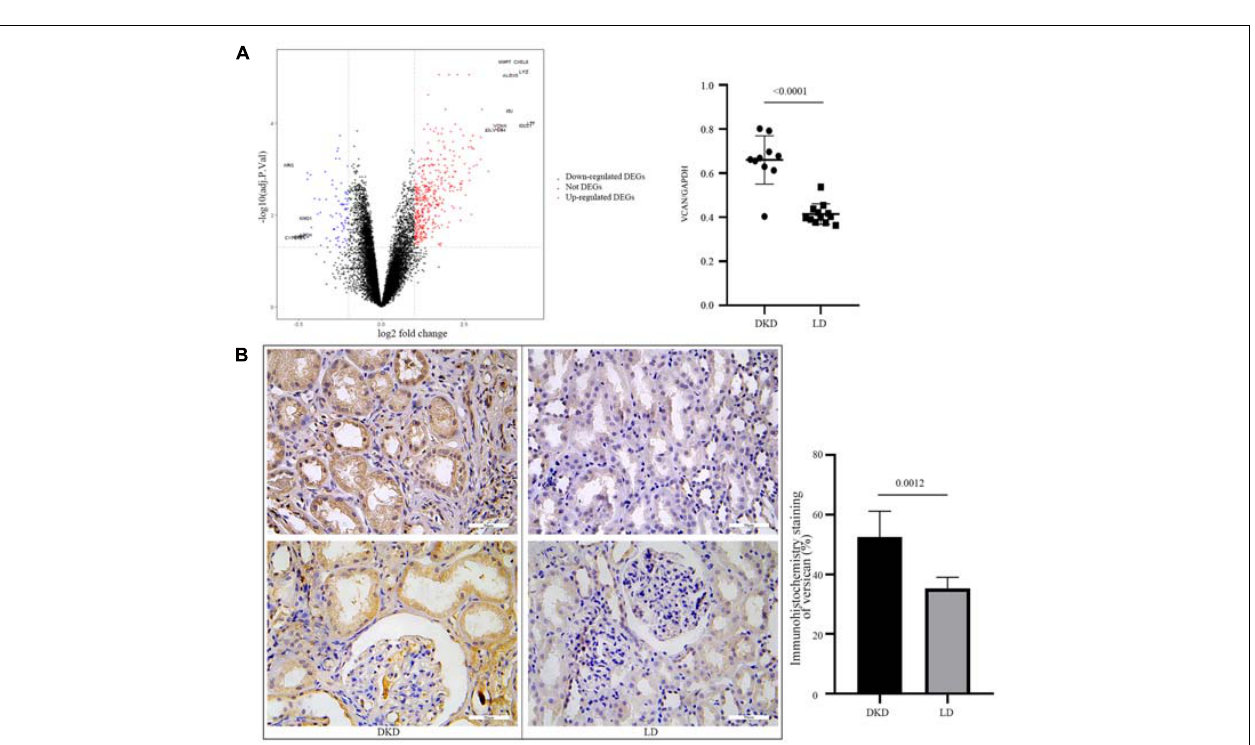
FIGURE 5 | Validation of VCAN in GSE30122. (A) Volcano plot of GSE30122 and the top 10 DEGs were annotated. Difference in relative VCAN transcription levels between DKD and LD, P < 0.0001. (B) Immunohistochemistry staining of versican in DKD and LD kidney